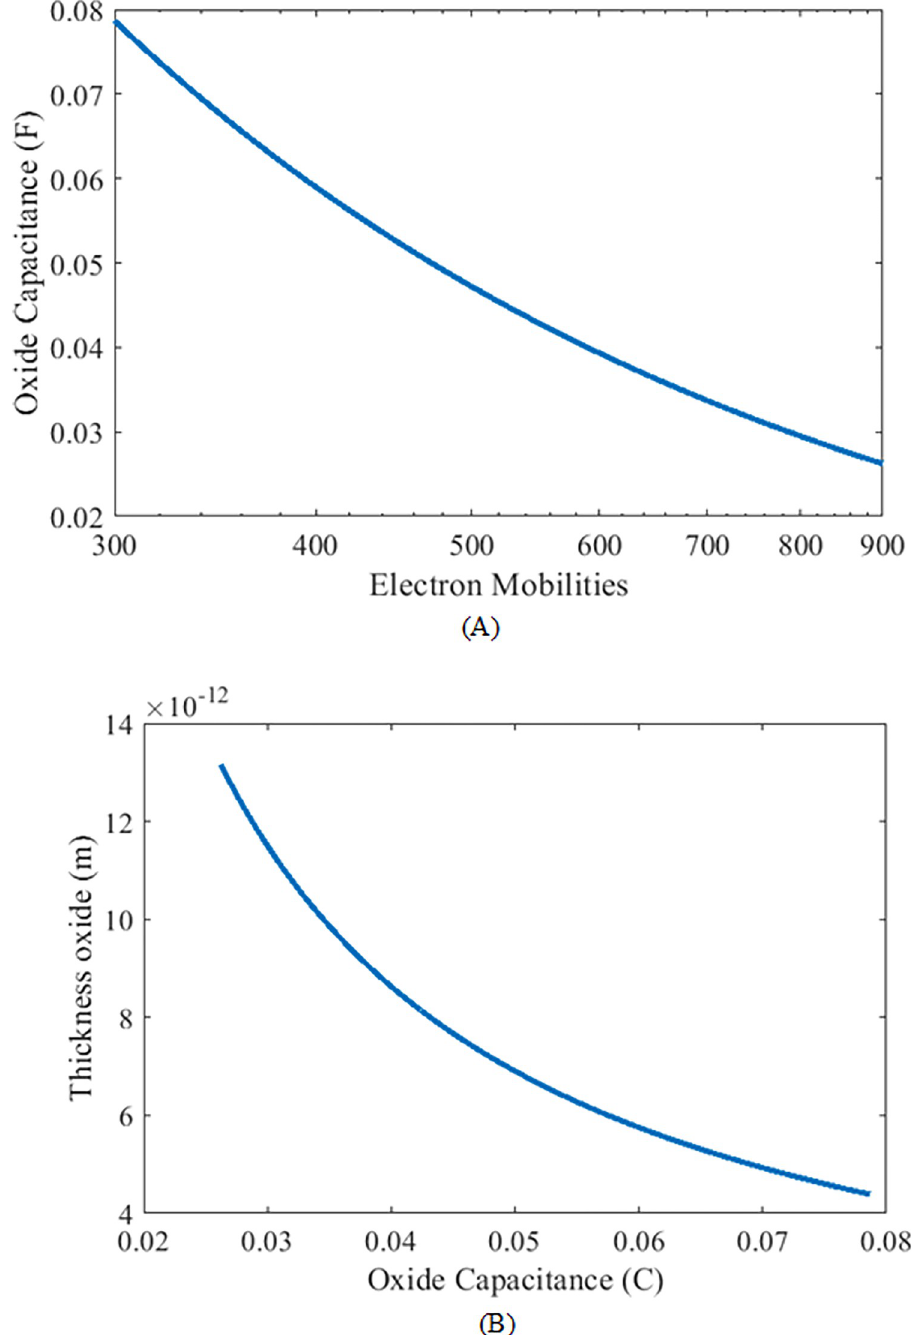
Fig 4. (A) Oxide capacitance as a function of electron motilities. (B) Thickness oxide as a function of Oxide capacitance. Where C has the same value that of C jo based MOSFET. From Fig 6 the input side, output side, and reverse side capacitance can be modelled by using (17), (18), and (19), respectively as ( C